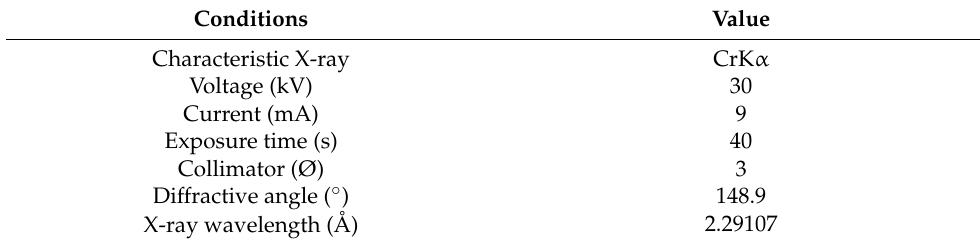
Figure 8. XRD equipment for measuring the residual stress (Xstress-3000 + G3). Table 4. Measurement conditions for the XRD